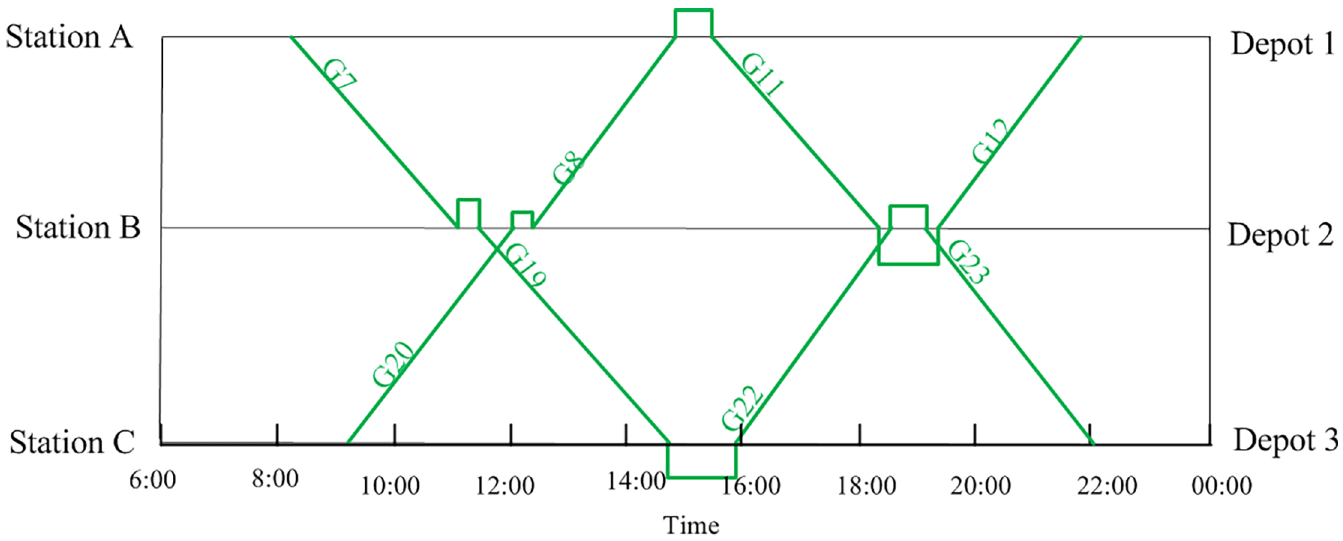
Fig 9. Specific EMU circulation plan based on the time-space diagram.